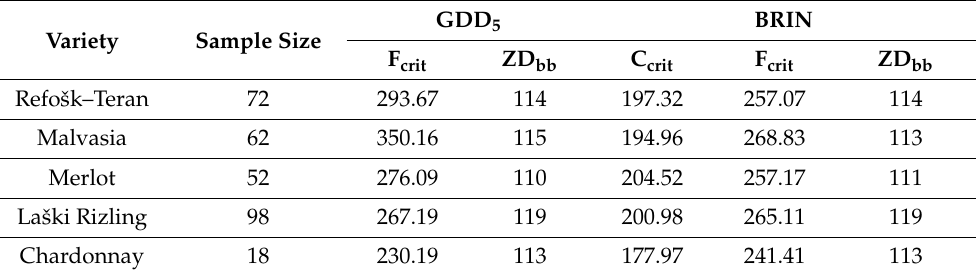
Table 3. Values of calculated parameter sets for several grapevine varieties and the two chosen phenological models used in this analysis: GDD 5 and BRIN (both with T b = 5 ◦